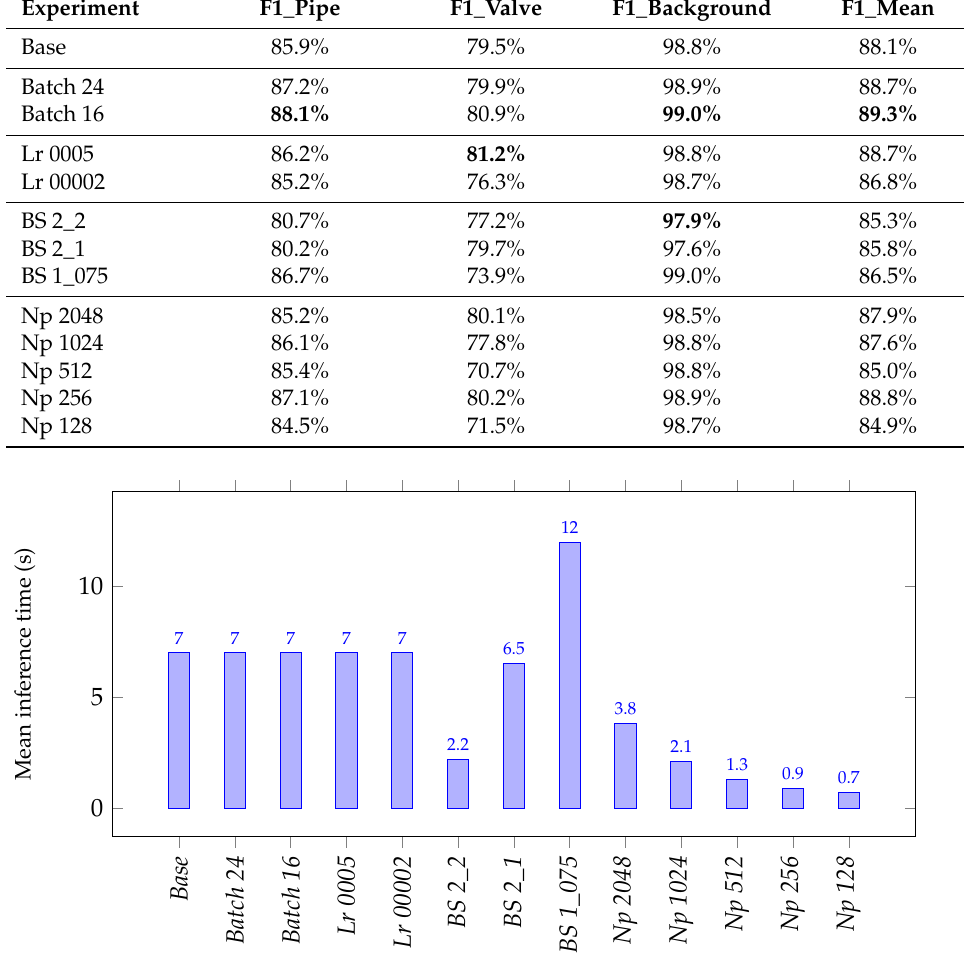
Figure 9. Sea test set mean inference